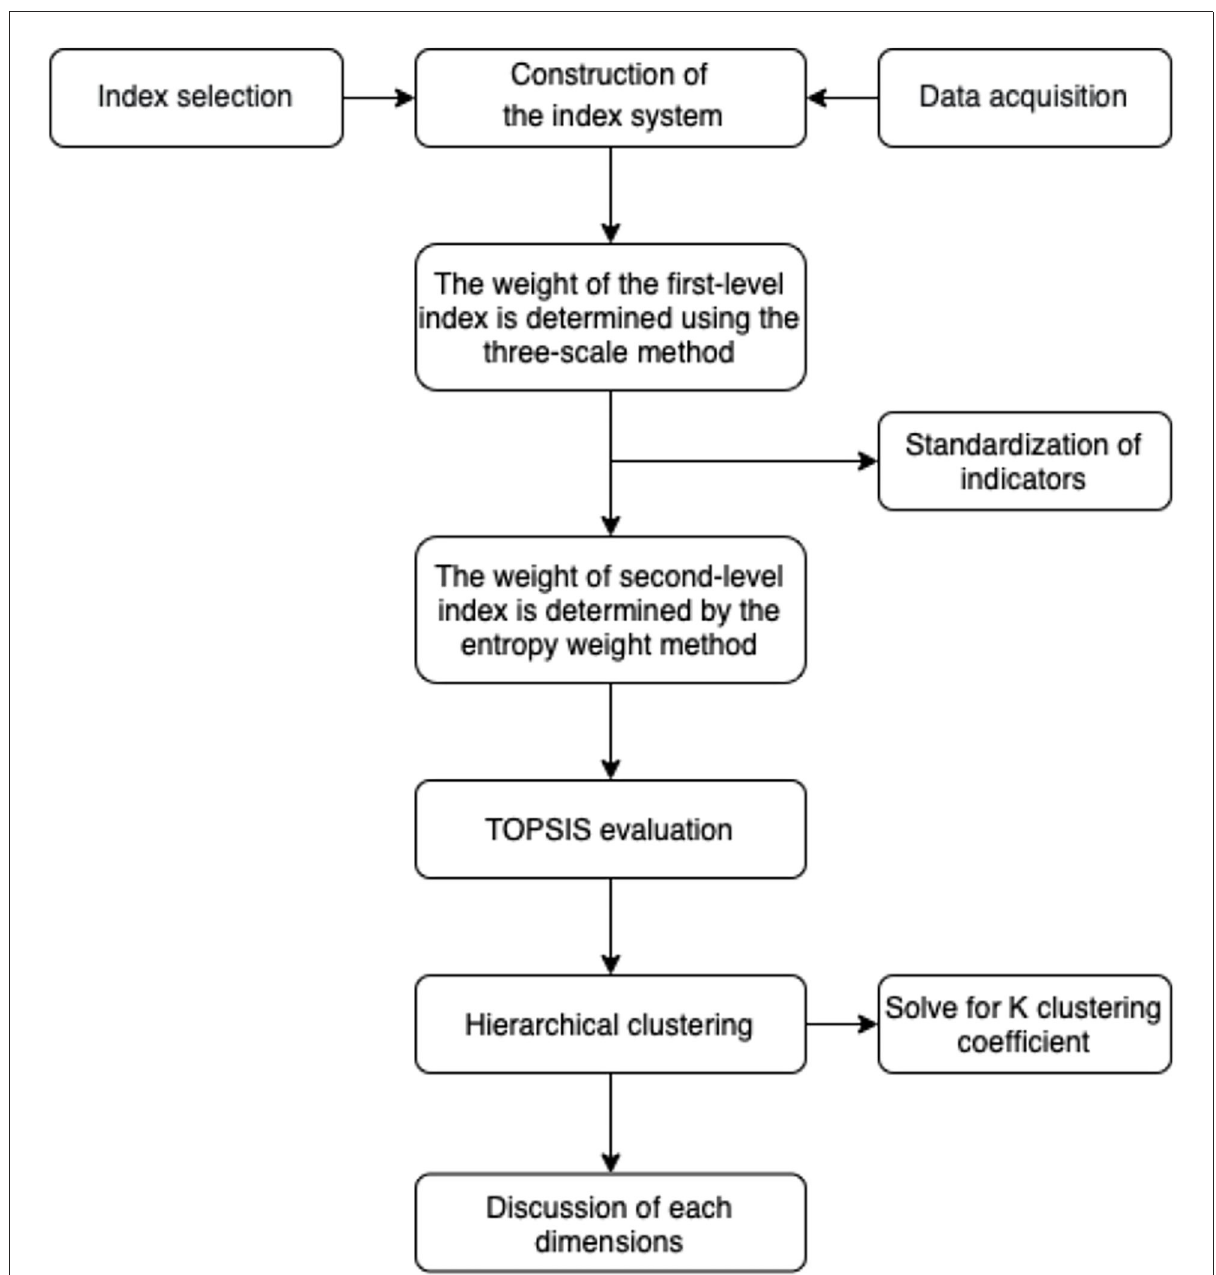
FIGURE2 Methodology flow